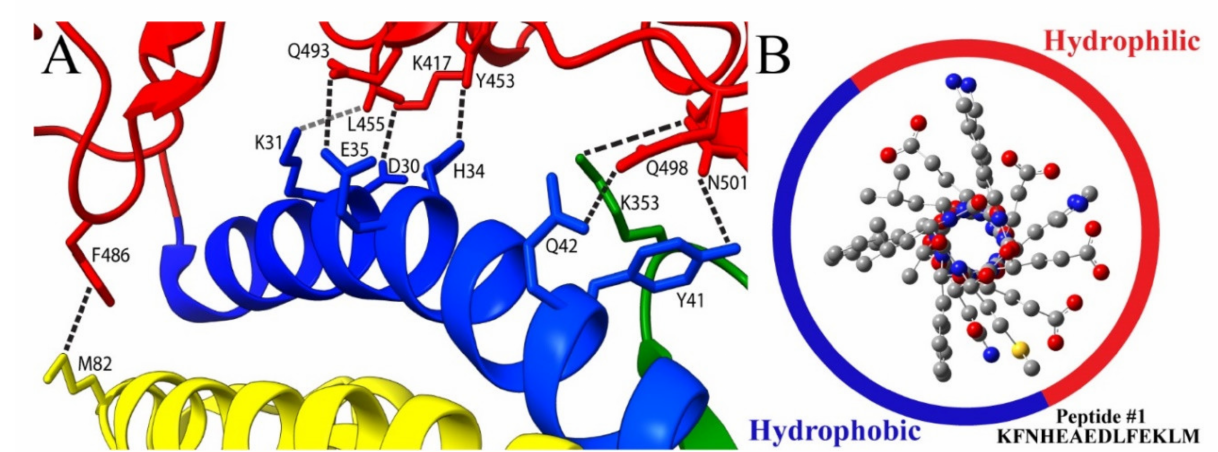
Figure 1. ( A ) SARS-CoV-2 spike RBD and human ACE2 complex based on the crystal structure. The blue, yellow, and green residues correspond to the ACE2 α 1 helix, α 2 helix, and β 3 linker, respectively. The red residues are from the viral spike protein. Residues involved in the binding are noted, and interactions are illustrated via dashed line. The structure is visualized using ChimeraX software. ( B ) View of helical peptide 1 looking down the central axis as constructed in GaussView molecular modeling software. Hydrophobic residues lie on the left side of the helix, while the majority of hydrophilic residues are on the right. The hydrogen atoms have been removed to improve visibility of the helical structure and residue positioning.